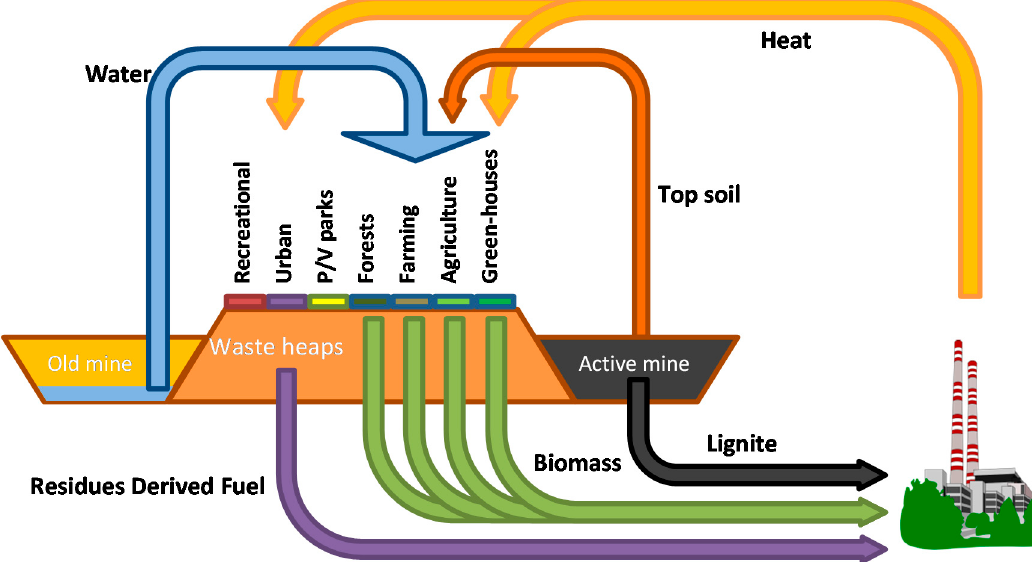
Figure 9. Schematic representation of circular economy practices applicable in surface lignite mines.